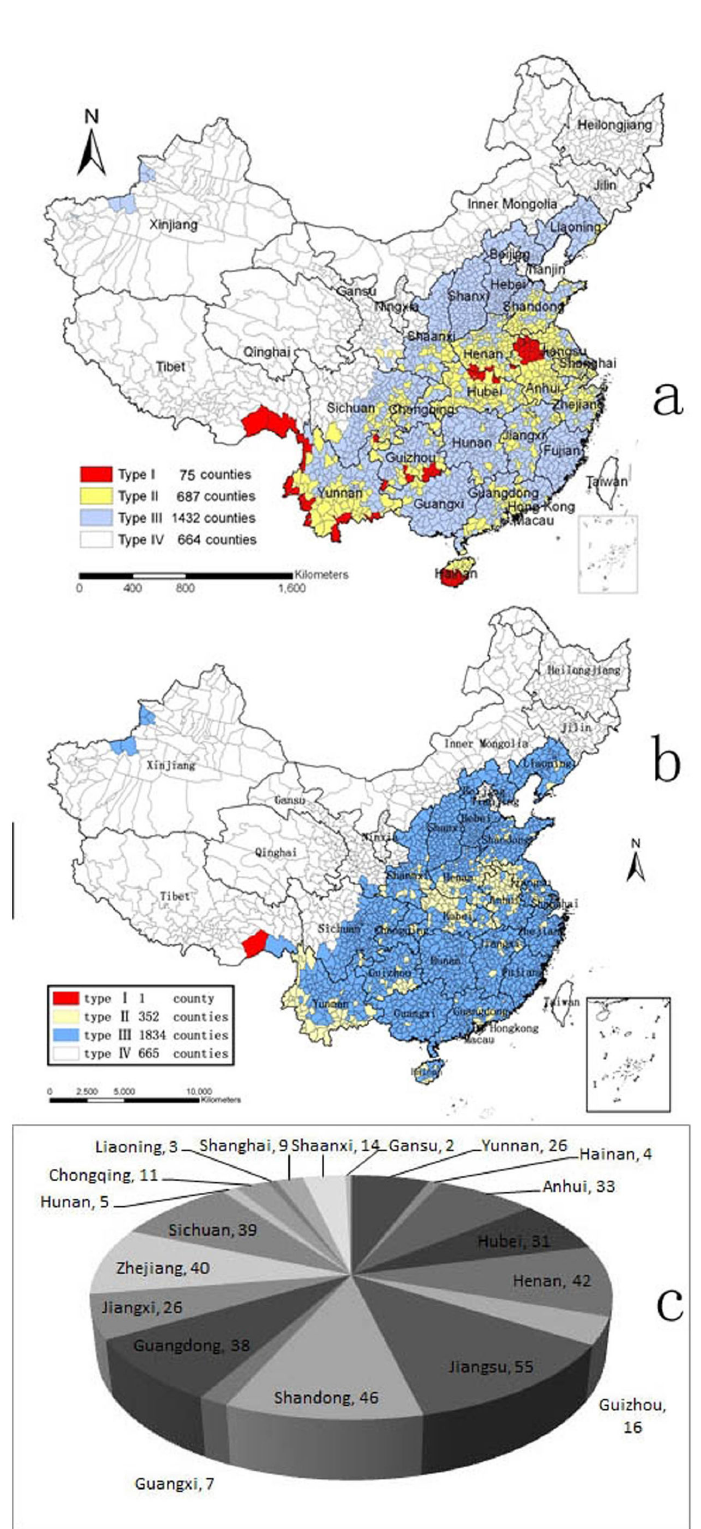
Figure 3. The Shifts of Four Types Malaria Endemic Counties, 2010-2012. a: endemic malaria counties’ distribution in APCME; b: endemic malaria counties’ distribution updated based on data between 2010 and 2012; c: distribution of new Type III counties originated from Type II counties. doi: 10.1371/journal.pone.0074228.g003 PLOS ONE |